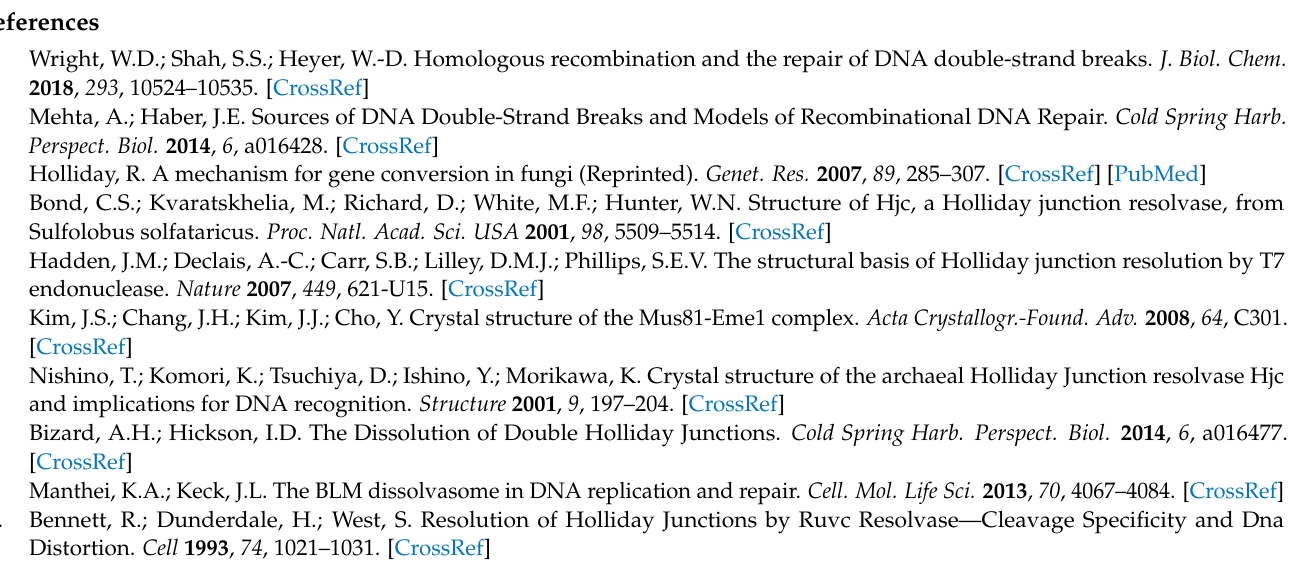
Figure S1. Multiple sequence alignment of RuvC homologs; Figure S2. Annealing of DNA substrates used in this study; Figure S3. Two Holliday junctions with different cores; Figure S4. HJ-0X cleavage assays; Figure S5. Time-resolved cleavage assay; Figure S6. The CD results of DrRuvC in different ion-containing